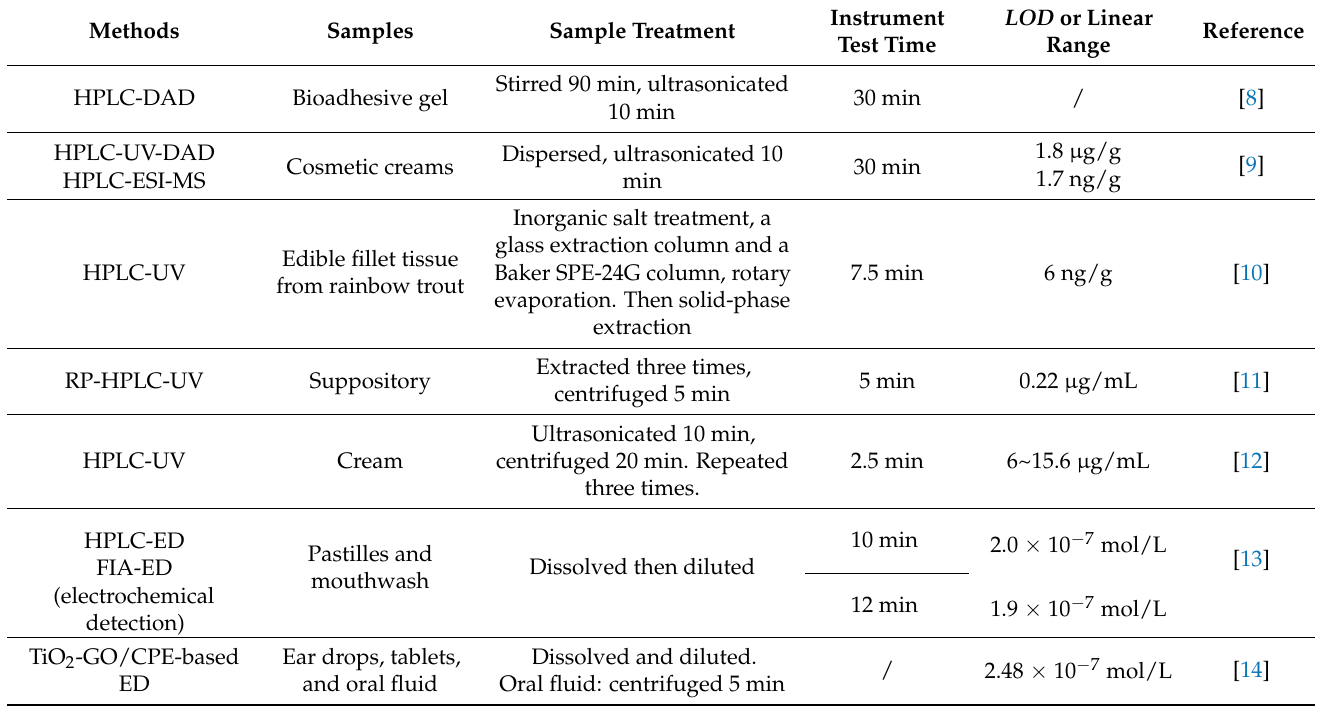
Table 2. Summary of current detection methods for benzocaine in the